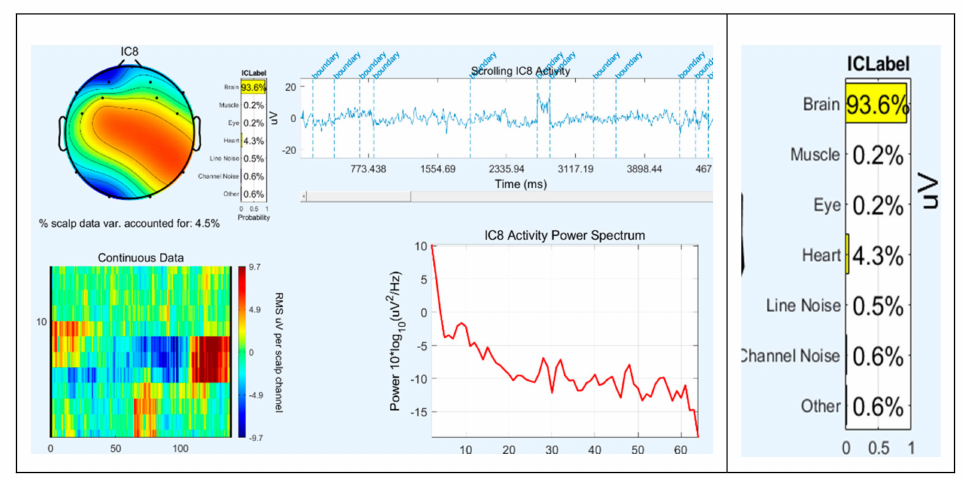
Figure 4. Example of the EEGLab ICALabel interface showing the properties of each